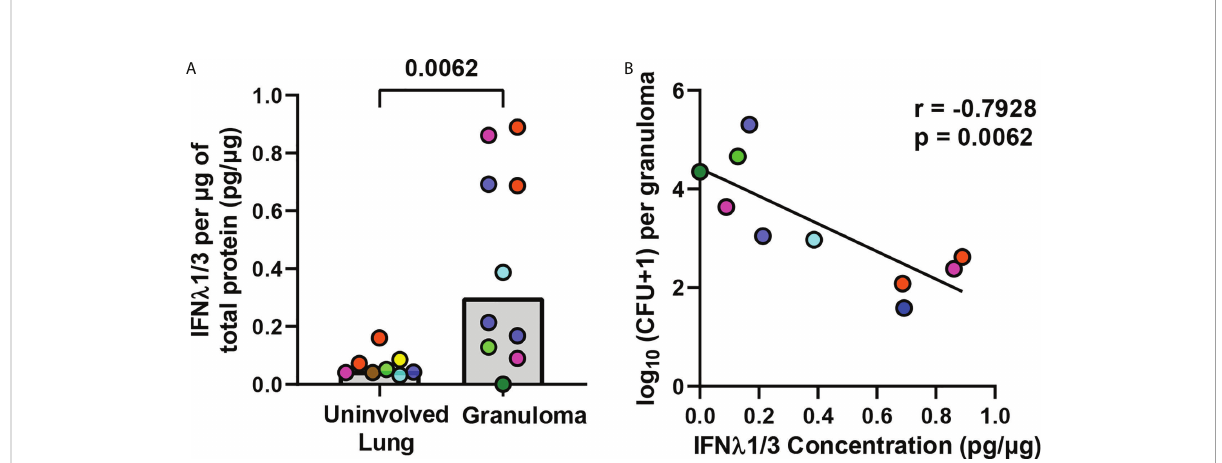
FIGURE 1 IFN l 1/3 expression in lung granulomas negatively correlates with bacterial burden. (A) IFN l 1/3 concentrations in non-diseased uninvolved lung (n=8) and lung granulomas (n=10) were normalized to total protein per sample and compared by ELISA. Bars represent median values. Statistical comparison by Mann-Whitney test for an unpaired comparison. (B) Correlation between log 10 transformed bacterial burden per granuloma and IFN l 1/3 concentration per granuloma. Pearson correlation coef fi cient and corresponding p-value reported and simple linear regression line